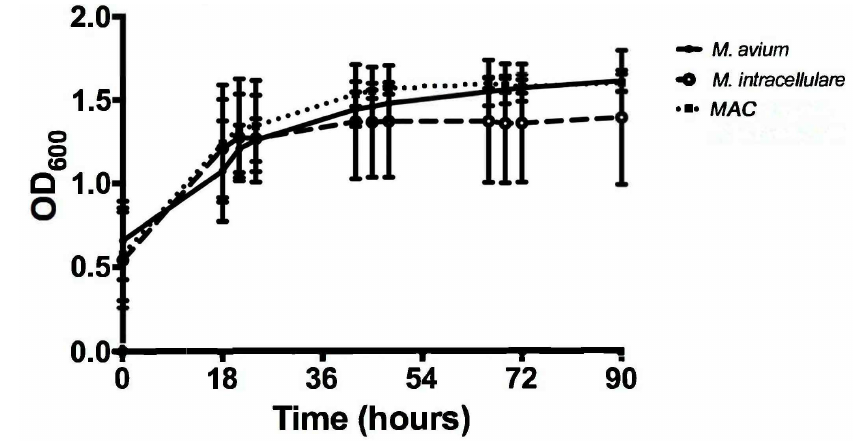
Figure 1. Optical density (OD) kinetics of M. avium (solid line, solid symbol), M. intracellulare (dashed line, open symbol), and MAC ( M. avium combined with M. intracellulare ) (dotted line with solid square symbol) over 90 h at 600 nm, n = 7.